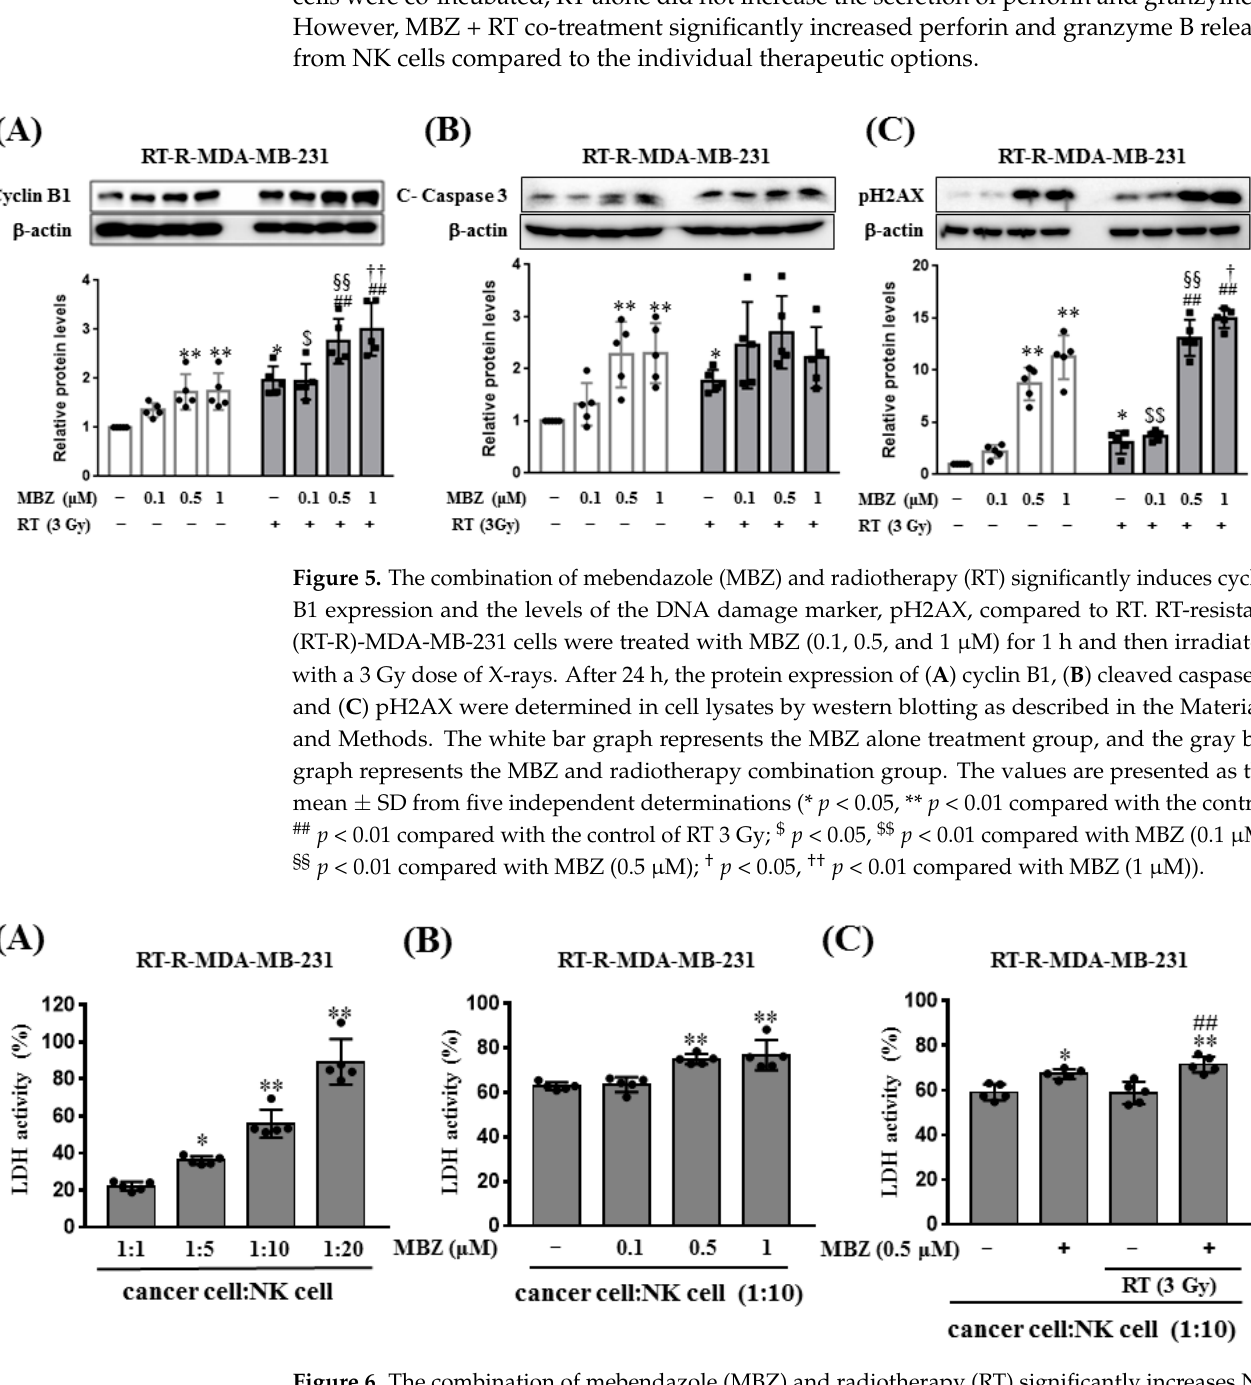
Figure 6. The combination of mebendazole (MBZ) and radiotherapy (RT) significantly increases NK cell-mediated cytotoxicity against RT resistant (RT-R)-MDA-MB-231 cells. ( A ) RT-R-MDA-MB-231 cells (5 × 10 3 cells/60 μ L) were seeded in round-bottom 96-well plates, and NK-92MI cells were added at the indicated ratios (1:1, 1:5, 1:10, and 1:20). After co-incubation for 4 h, LDH was measured in cell supernatants. ( B ) RT-R-MDA-MB-231 cells were treated with MBZ (0.1, 0.5, and 1 μ M) for 24 h, and the cells were collected and seeded in a round-bottom 96-well plate (5 × 10 3 cells/60 μ L/well). Next, NK-92MI cells (1:10 ratio) were added to the 96-well plate, co-incubated for 4 h, and LDH was measured in the cell supernatant as described in the Methods. ( C ) RT-R-MDA-MB-231 cells were treated with MBZ (0.5 μ M) for 1 h and then irradiated with a 3Gy dose of X-rays. After 24 h, the cells (5 × 10 3 cells/60 μ L) were seeded in a round-bottom 96-well plate, and NK-92MI cells (1:10 ratio) were added. After co-incubation for 4 h, LDH was measured in the cell supernatant as described above. The values are presented as the mean ± SD (* p < 0.05, ** p < 0.01 compared with the control; ## p < 0.01 compared with the control of RT 3 Gy). Figure 7. The combination of mebendazole (MBZ) and radiotherapy (RT) more efficiently induces perforin and granzyme B production by NK cells compared to RT. RT-resistant (RT-R)-MDA-MB- 231 cells were treated with MBZ (0.5 μ M) for 1 h and then irradiated with a 3 Gy dose of X-rays. After 24 h, the cells were seeded in a round-bottom 96-well plate, and NK-92MI cells (1:10 ratio) were added. After co-incubation for 4 h, ( A ) perforin and ( B ) granzyme B were measured in cell supernatants as described in the manufacturer’s protocol. The values are presented as the mean ± SD (* p < 0.05, ** p < 0.01 compared with the control; ## p < 0.01 compared with the control of RT; $$ p < 0.01 compared with MBZ).